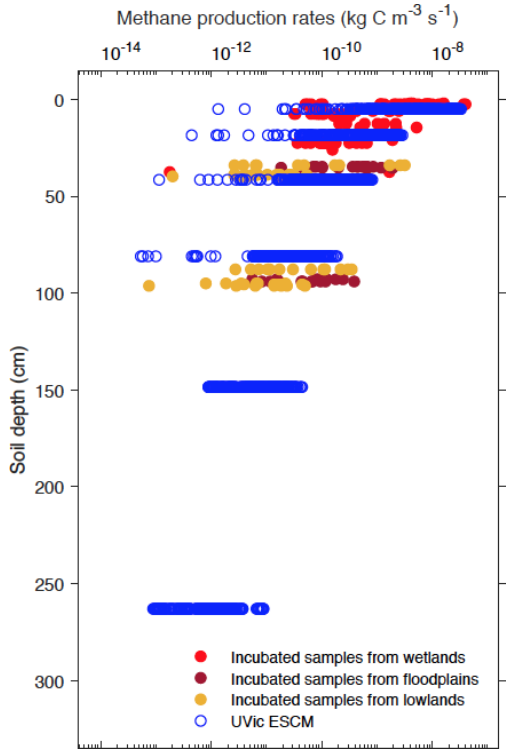
Figure 3. Vertical profiles of simulated and potential CH 4 produc- tion rates from wetlands across Alaska. Potential CH 4 production rates are measurements from laboratory incubations of soil samples collected from various anaerobic ecosystems (Treat et al., 2015). Both simulated and measured CH 4 production rates are shown here with a log-transformed axis (base-10 logarithmic scale).